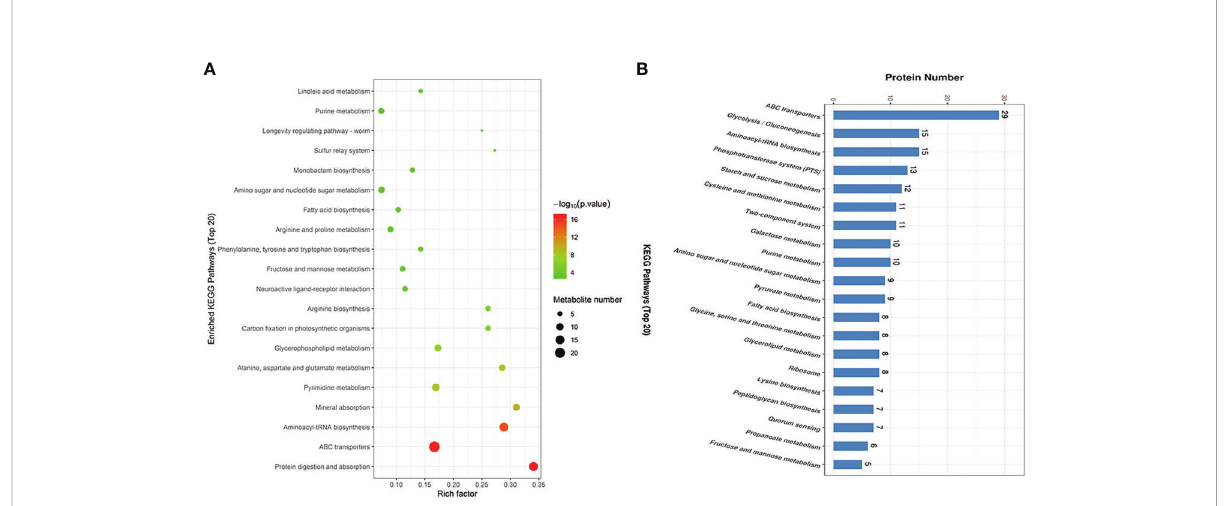
FIGURE 5 The enriched KEGG pathways of the DMs and DEPs in SC19 compared to EGCG treated SC19. (A) Enrichment analysis of the differential metabolites. Rich factor represents the ratio of the number of DMs to total metabolites in each pathway. (B) Enrichment analysis of the differently expressed proteins. The top 20 KEGG pathways were shown on the graph.